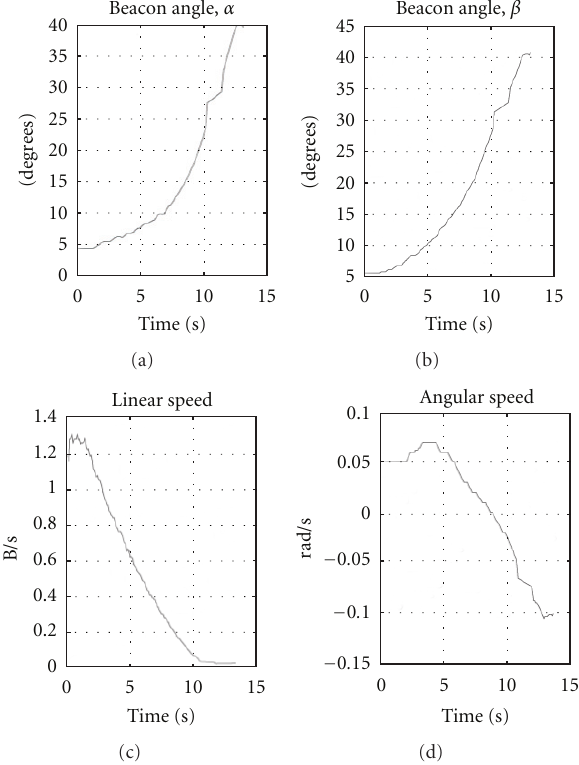
Figure 13: The changes in α , β , and the control signals for the first experiment.